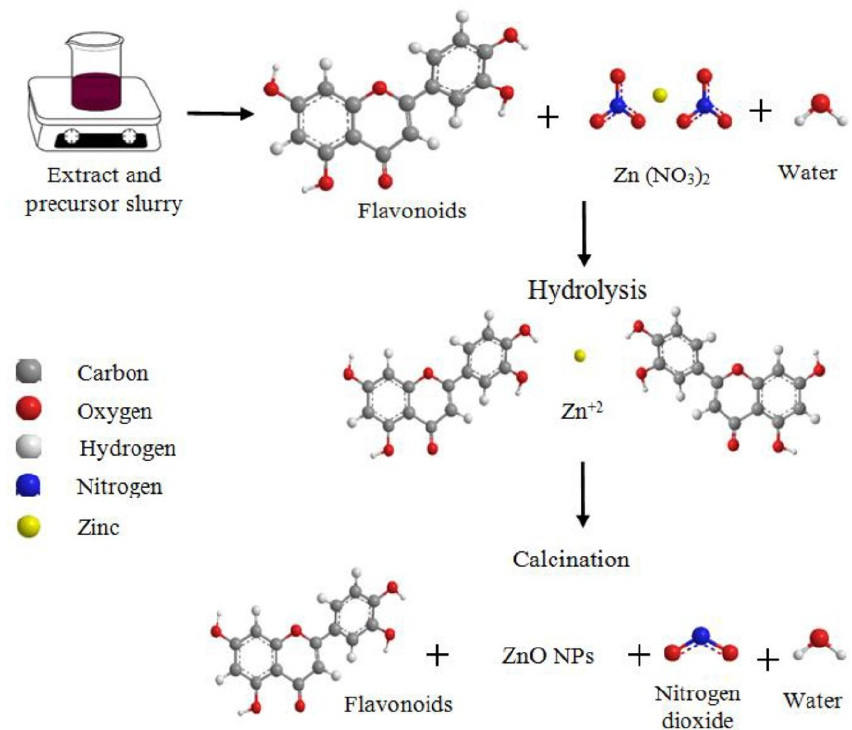
Figure 6. Synthesis route of ZnO nanoparticles. Reprinted with permission from Ref. [44]. Copyright 2021 Elsevier.